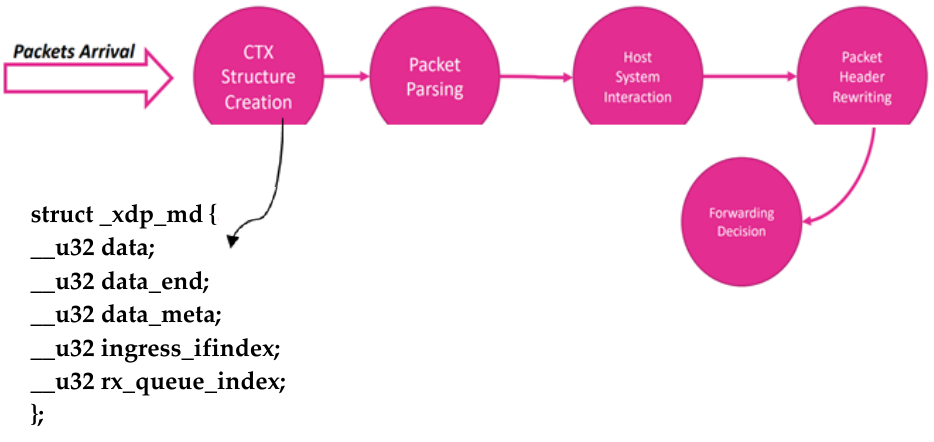
Figure 3. XDP program lifecycle.